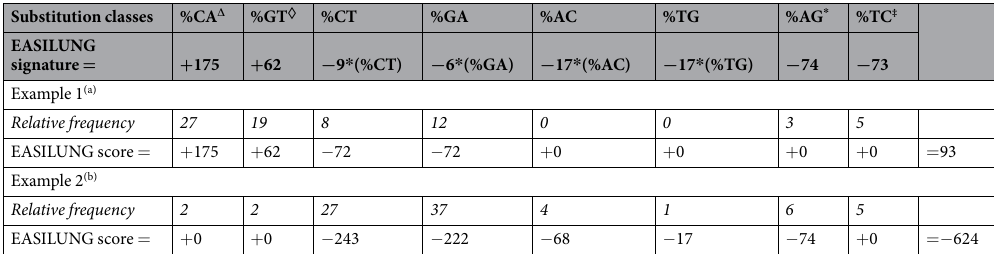
Table 4. Calculating the EASILUNG score with two examples from the TCGA. %CA = relative frequency of C > A substitutions (%); %GT = relative frequency of G > T substitutions (%); %CT = relative frequency of C > T substitutions (%); %GA = relative frequency of G > A substitutions (%); %AC = relative frequency of A > C substitutions (%); %TG = relative frequency of T > G substitutions (%); %AG = relative frequency of A > G substitutions (%); %TC = relative frequency of T > C substitutions (%). ∆ For samples with %CA > 12. ◊ For samples with %GT > 13. * For samples with %AG > 5. ‡ For samples with %TC > 5. (a) Example